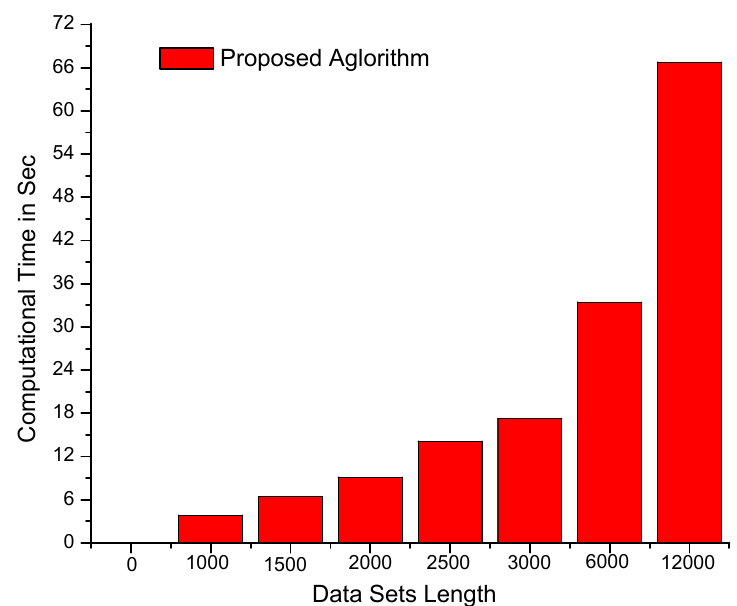
Figure 5. Computational time (in seconds) of the proposed algorithm on larger data sets (12,000 × 12,000 values) (the computational time increases linearly with respect to the size of data sets).